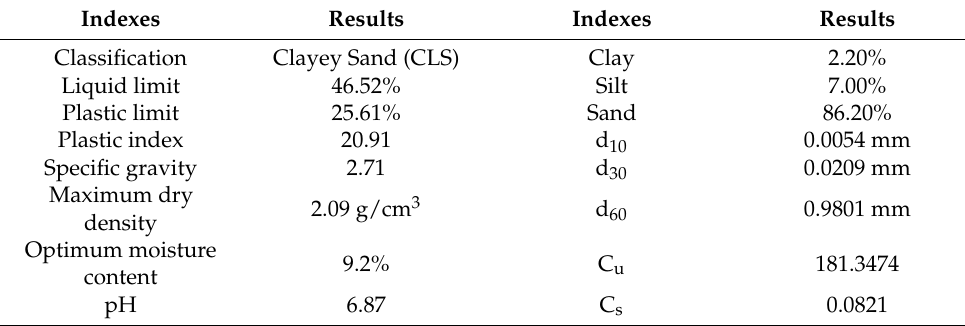
Table 1. Physical properties of the